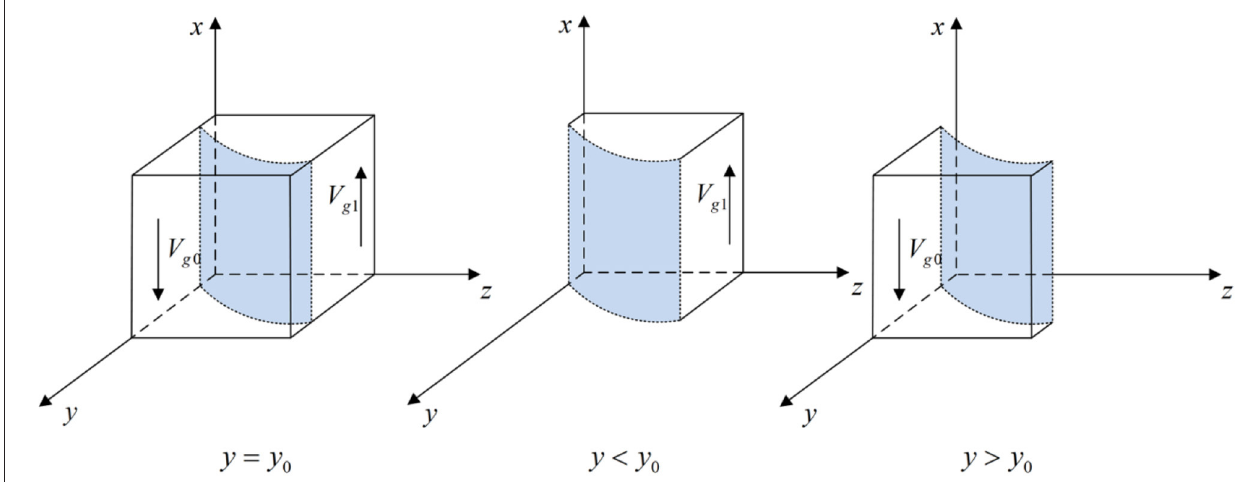
FIGURE 2 | Phase diagram of the local government strategic choice. Figure is the phase diagram that shows the evolutionary trend of local government’s strategy obtained by calculating the response function of the probability of local government choosing the “strict supervision”